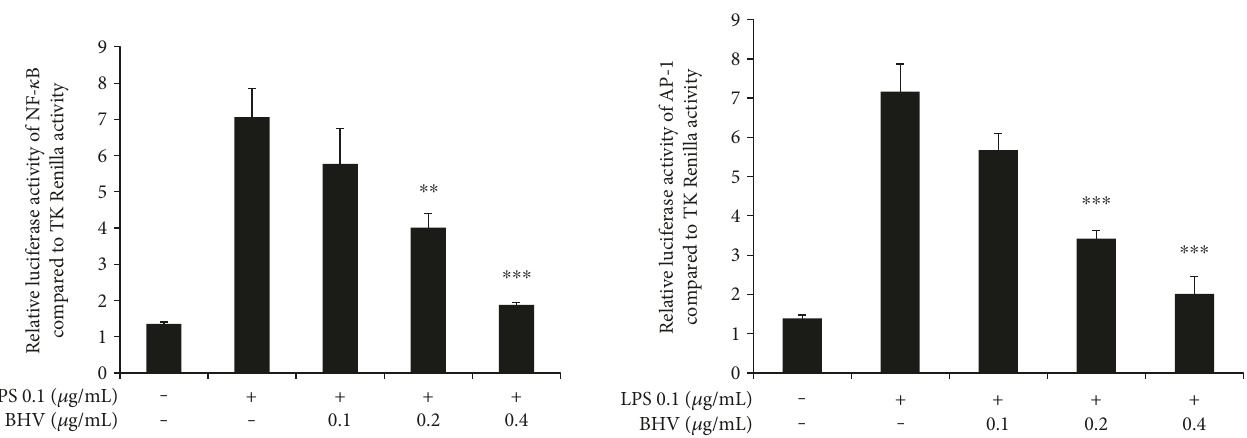
Figure 6: E ff ects of B. hebetor venom on NF- κ B and AP-1 transcriptional activities. HEK 293T cells were cultured in 24-well plates and after 18hr of incubation were transfected with NF- κ B, AP-1, and TK Renilla plasmids using the calcium-phosphate method. 48 hr after transfection, cells were pretreated with indicated concentrations of BHV (0.1 μ g/mL – 0.4 μ g/mL) and then stimulated with PMA (0.1 μ M) for 6hr. Luciferase activity was later measured using Dual-Glo luciferase assay system. NF- κ B and AP-1 activity was normalized to TK Renilla activity and concentrations were compared to PMA Renilla luciferase activity. Bar graph is mean ± SEM of triplicates. ∗∗∗ p < 0 001 and ∗∗ p < 0 005 were considered statistically signi fi